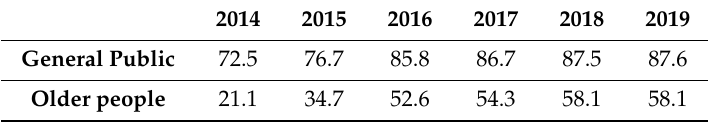
Table 13. Utilization Rate of e-Government in